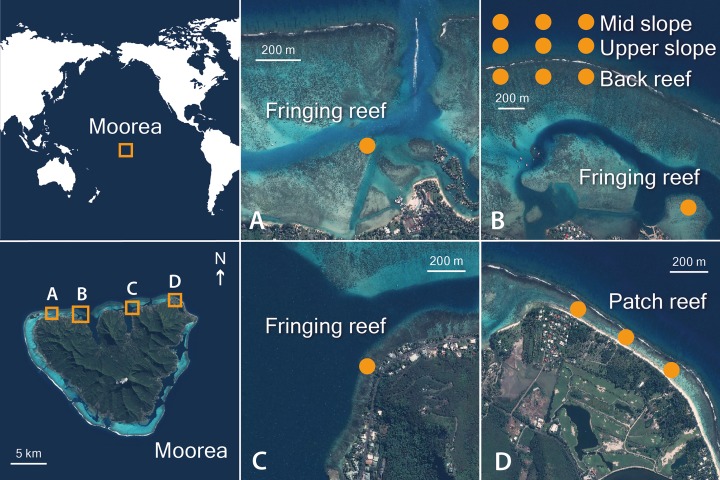
Aerial views of the locations of each transect in the five surveyed habitats in Moorea, French Polynesia.The names of these surveyed locations are: (A) Tiahura, (B) Papetoai, (C) Cook’s Bay and (D) Temae. Map data WorldView–2, Digital Globe.